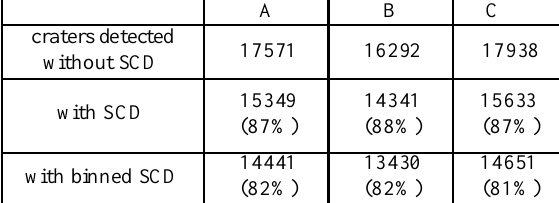
Table 2. Number of detected craters in test regions A, B and C.